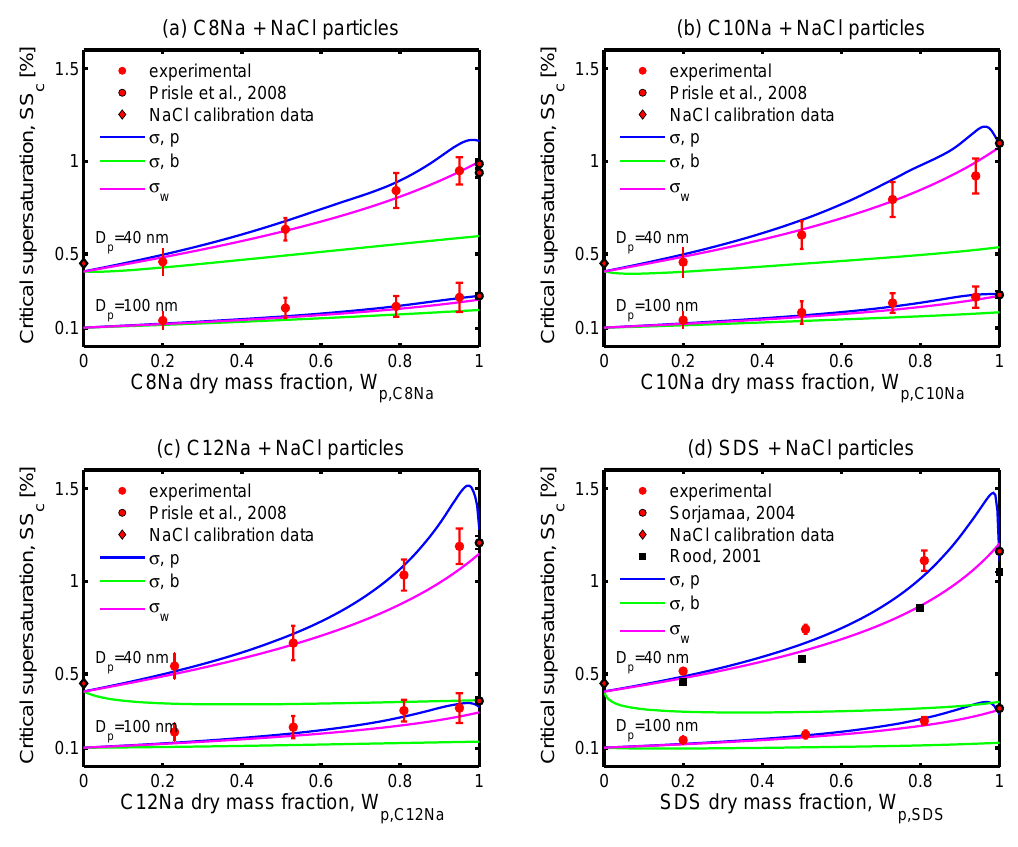
Fig. 6. Critical supersaturations ( SS c [ % ] ) for particles with increasing dry mass fractions ( W p, SFT ) of (a) sodium octanoate (C8Na), (b) sodium decanoate (C10Na), (c) sodium dodecanoate (C12Na), and (d) sodium dodecyl sulfate (SDS), measured in experiments and modeled with the three different surfactant representations ( σ,p , σ,b , and σ w ). Experimental values from Sorjamaa et al. (2004) and Prisle et al. (2008) for pure surfactant particles, and from Rood and Williams (2001) for mixed SDS-NaCl particles, as well as calibration data for pure NaCl particles, are included for comparison. Results are shown for selected dry particle sizes, D p = 40nm (upper curves and data points) and D p = 100nm (lower curves and data